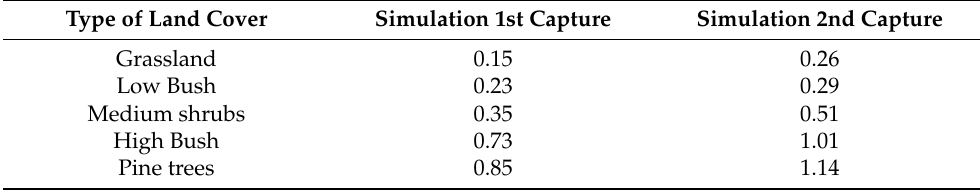
Table 2. Leaf area index (LAI) values assigned to the two LiDAR-PNOA captures.